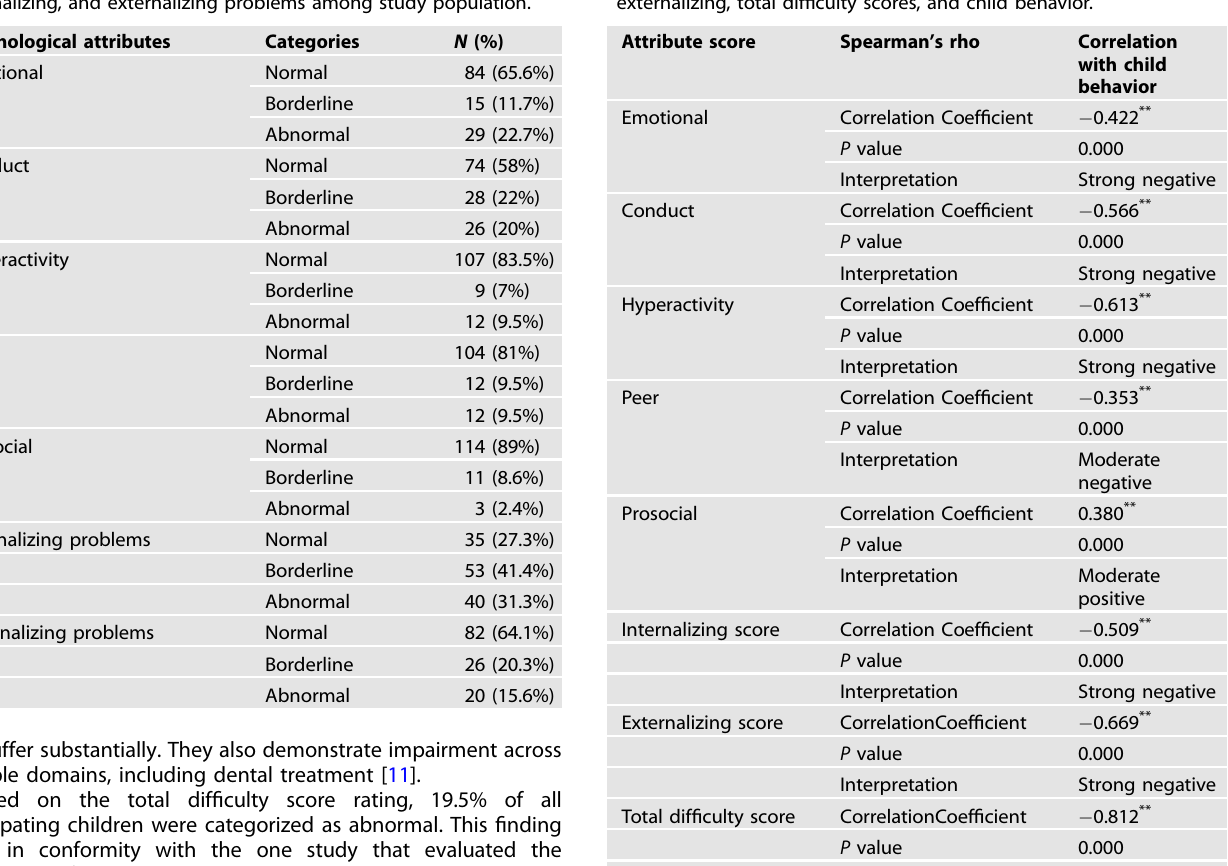
Table 3. Correlation between psychological attributes, internalizing, externalizing, total dif fi culty scores, and child behavior.